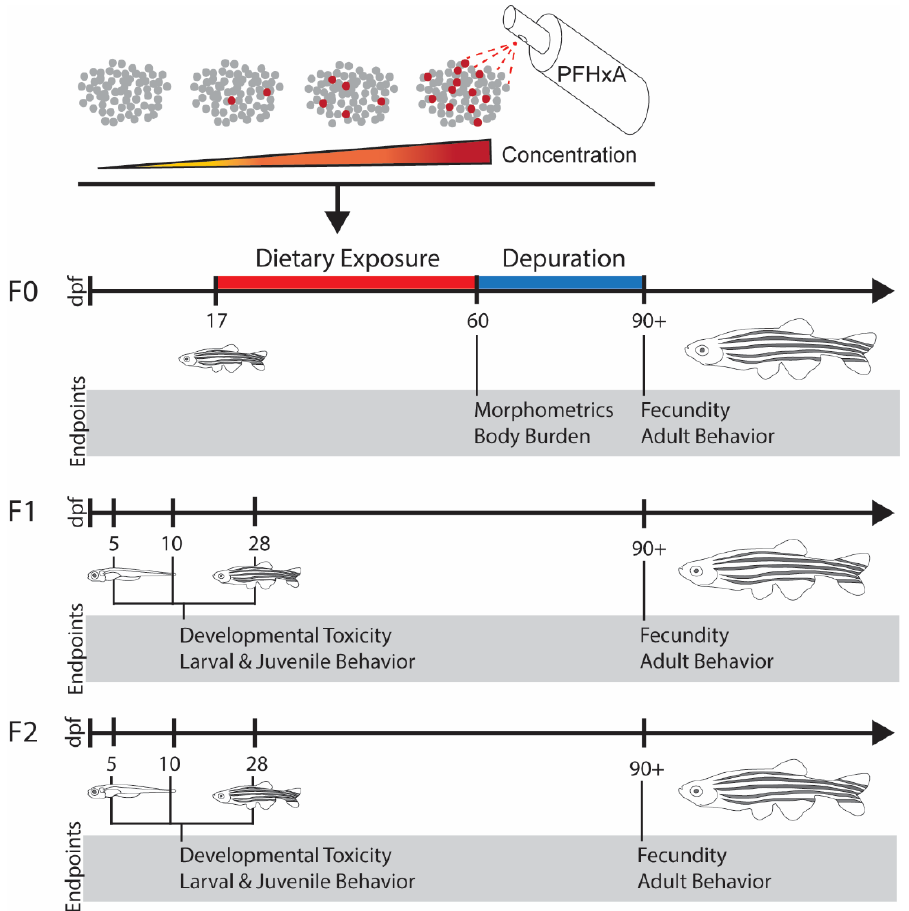
Figure 1. Experimental Overview. F0 zebrafish were dietarily exposed from 17 to 59 days post fertilization (dpf) to diets contaminated with (left to right) 0 (control), 1, 10, or 100 ng/g PFHxA. Immediately following dietary exposure, measurements of morphometrics and body burden were performed. Following a subsequent depuration period, fecundity and adult behavior were assessed after 90 dpf. One spawning event was used to generate the F1 generation, which underwent assessments of developmental toxicity, larval and juvenile behavior, fecundity, and adult behavior. The same experimental protocols were used to interrogate transgenerational effects in the F2 generation.